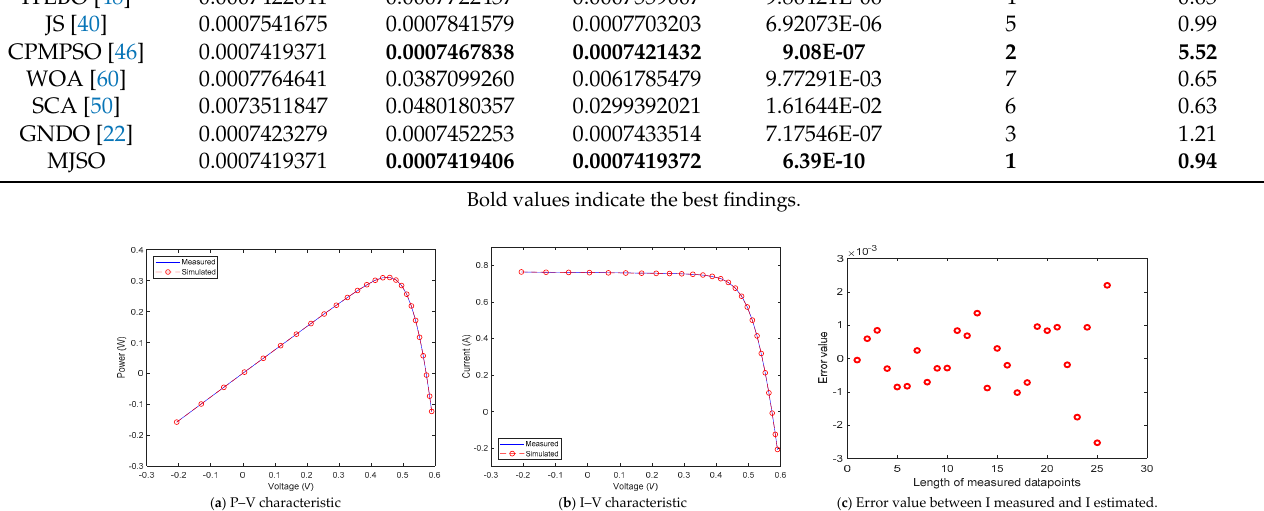
Table 9. Comparison of the DDM.